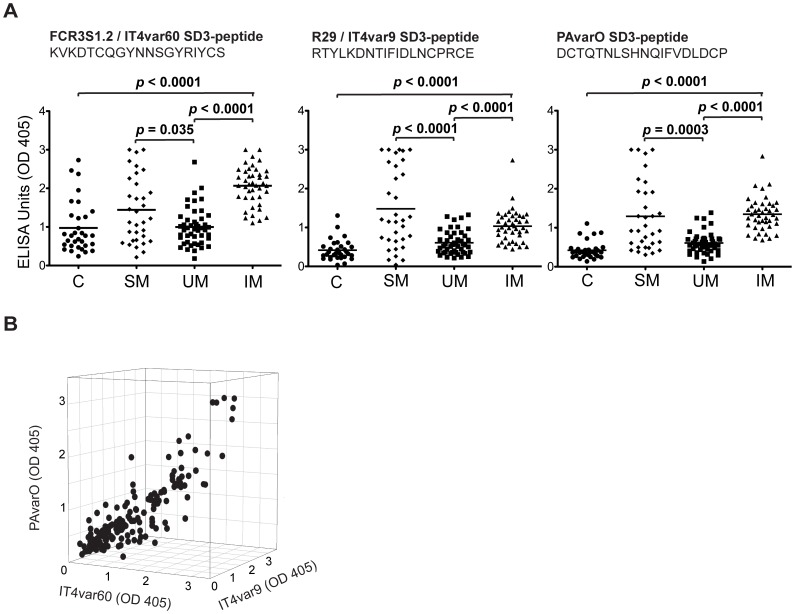
Individuals living in endemic areas acquire antibodies against SD3-loop sequences. A:IgGs levels in human sera (diluted 1∶1000) against the NTS-DBL1α SD3-loop peptides from parasites IT4var60, IT4var9 and PAvarO as detected by ELISA. IgG levels were measured in 32 non-immune Swedish controls(C), 33 patients with severe malaria (SM), 47 patients with uncomplicated malaria (UM) and 40 immune adults (IM). B: Correlation between patient-serum IgG reactivity as measured by ELISA with the SD3-loop peptides KVKDTCQGYNNSGYRIYCS (IT4var60), DCTQTNLSHNQIFVDLDCP (PAvarO) and RTYLKDNTIFIDLNCPRCE (IT4var9). The sera were tested for reactivity towards the three distinct peptides in ELISA (as described under B) and the correlation was tested using non-linear regression; R2 = 0.75, p<0.0001.